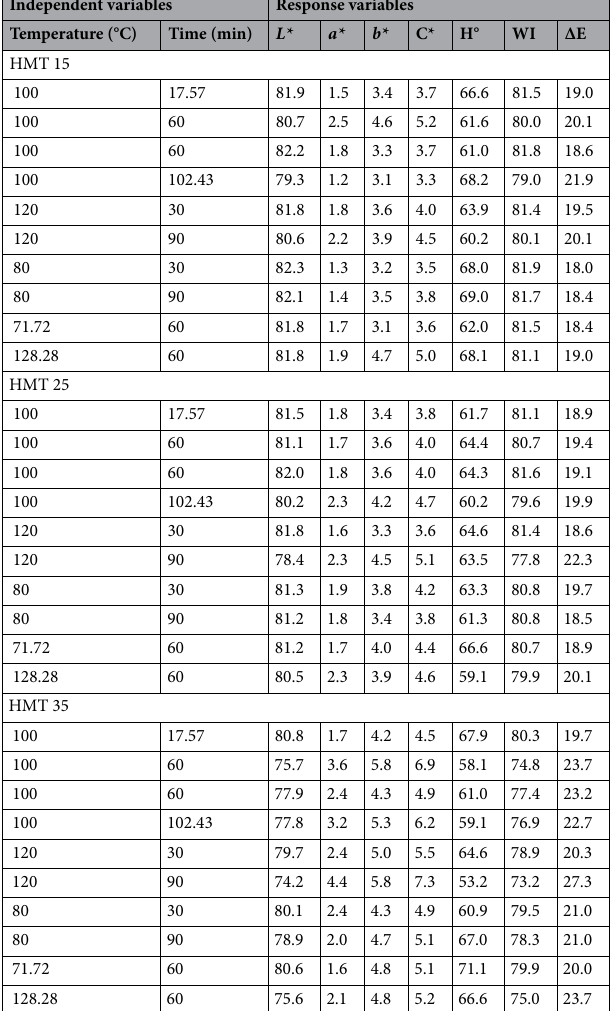
Table 2. Levels of process variables and values for colour characteristics of heat-moisture treated Bambara groundnut under different treatment conditions. L* : lightness/darkness; a* : redness/greenness; b* : yellowness/ blueness; C*: chroma; H°: hue angle; WI: whiteness index; ∆E: total colour difference. Total colour difference (ΔE) is a noticeable difference, where the observer does not notice the difference 38